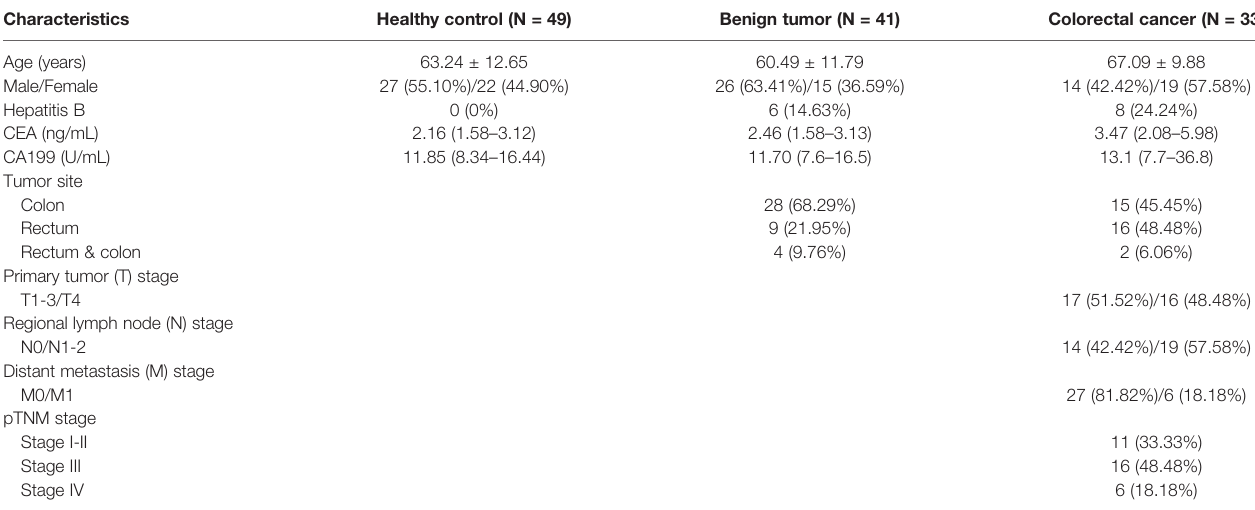
TABLE 1 | Basic characteristics of the colorectal cancer, benign tumor, and healthy control groups. Characteristics Healthy control (N = 49) Benign tumor (N =